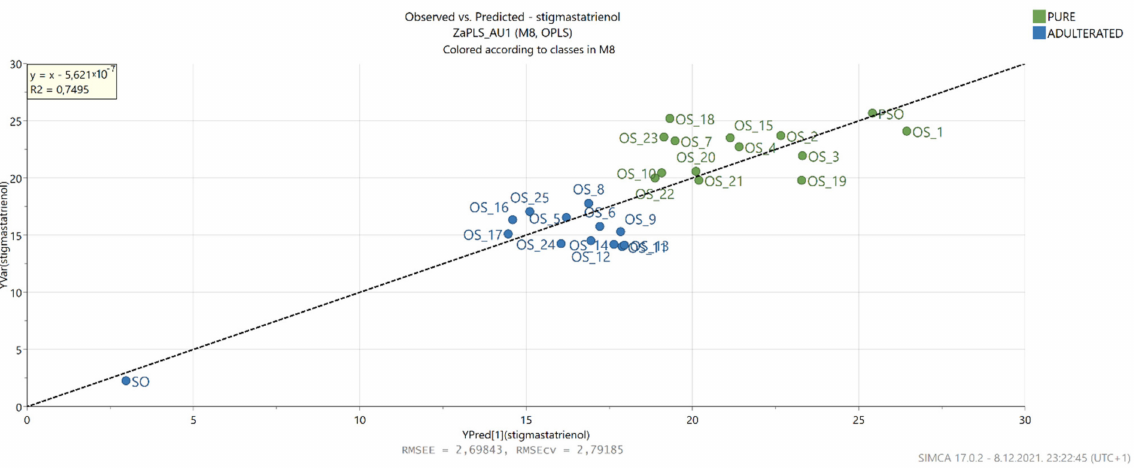
Figure 8. Actual and predicted ∆ 7,22,25-stigmastatrienol levels based on the OPLS model built with NIR spectrometry